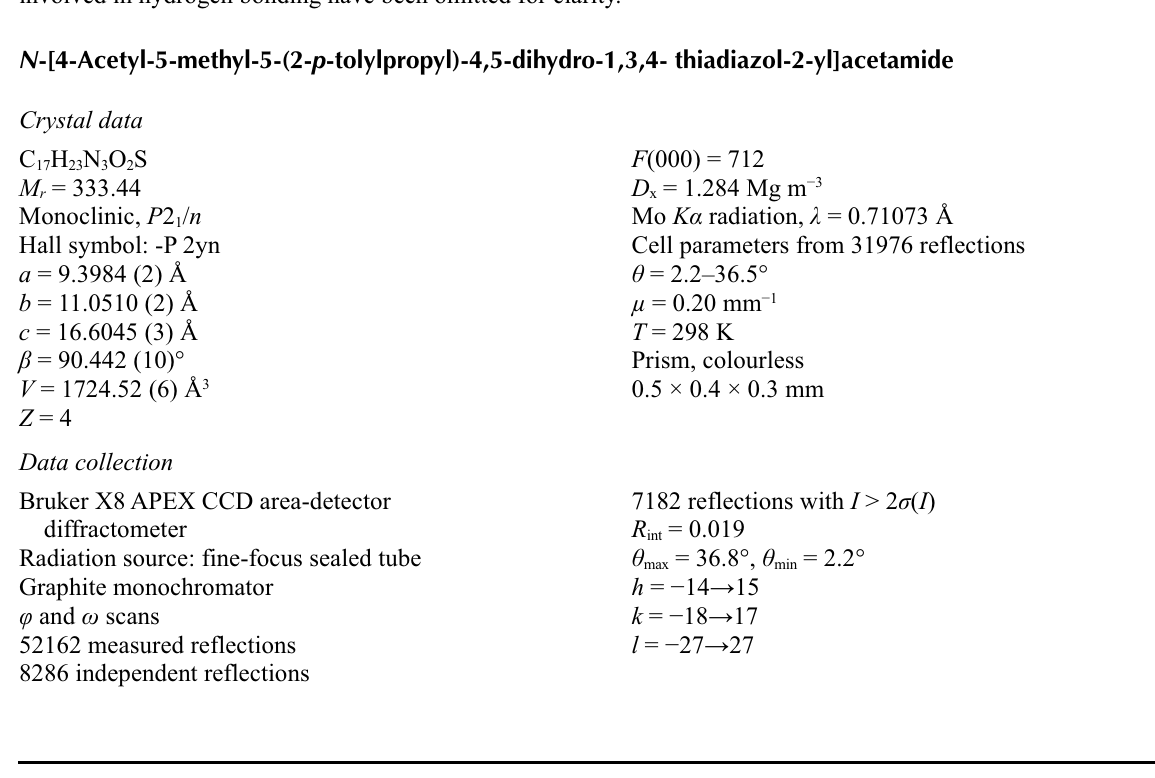
Figure 2 Partial packing view showing N—H···O hydrogen-bonded (dashed lines) chain running along the b axis. H atoms not involved in hydrogen bonding have been omitted for